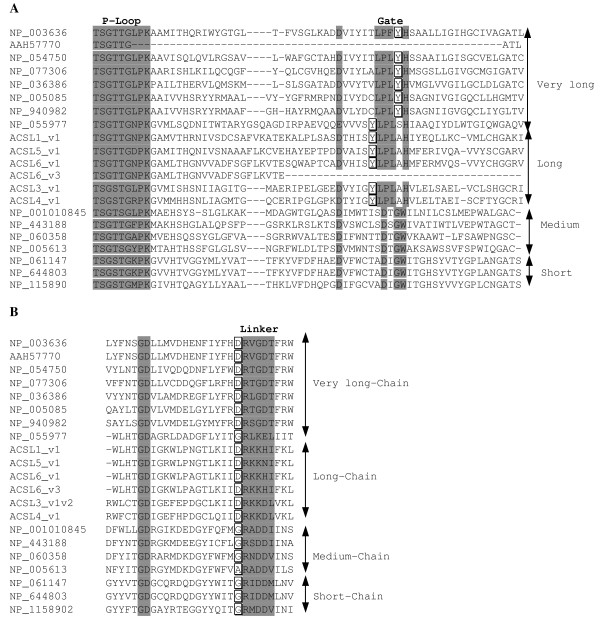
Gate (A) and linker (B) domains of human acyl-CoA synthetase family members. The Y residue of the Gate domain for long and very-long-chain ACS is boxed. The D and G residues of the Linker domains are boxed. GenBank accession numbers for short, medium, long and very-long chain are indicated on the left. The Gate domain of BG1 is of the long-chain type but its Linker is of the short-medium type. Lipidosin is a soluble ACS very-long-chain isoform found in brain tissue and is known to have a broader substrate range than other very-long ACS [17, 18].